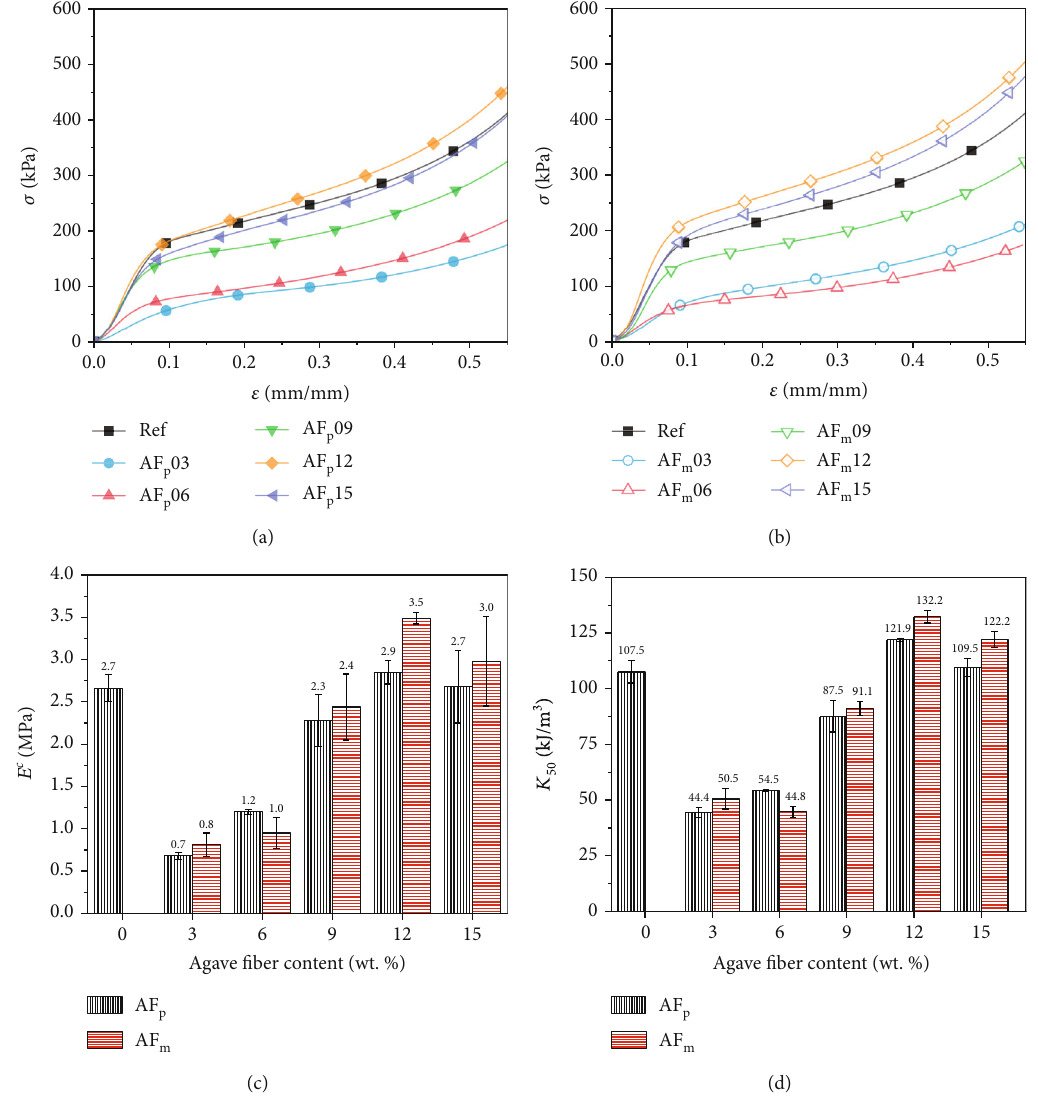
Figure 7: Mechanical properties of the cellular plastics under compression. (a) Representative σ vs. ε curves for foams with AF representative σ vs. ε curves for foams with AF